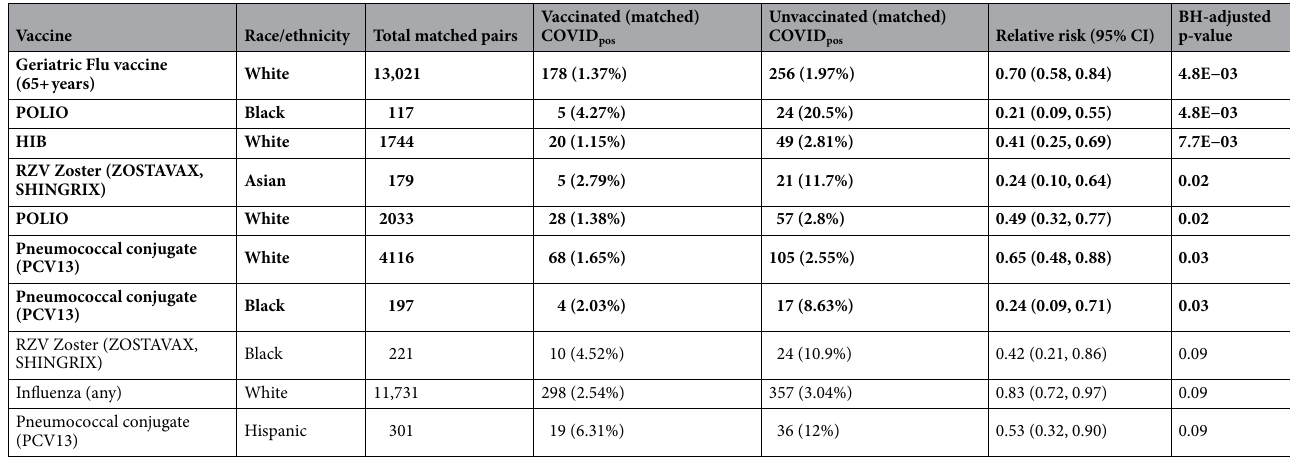
Table 7. Summary of SARS-CoV-2 rates for race/ethnicity-stratified vaccinated and unvaccinated propensity score matched cohorts (1 year time horizon). Table of SARS-CoV-2 infection rates for vaccinated and unvaccinated (matched) race/ethnicity subgroup cohorts for vaccines administered within 1 year prior to PCR testing. Only rows with adjusted p-values ≤ 0.1 are included. Rows in which the SARS-CoV-2 rate is lower (adjusted p-value < 0.05) in the vaccinated cohort are highlighted in bold. The columns are (1) Vaccine: Name of the vaccine, (2) Race/ethnicity: Race/ethnicity subgroup, (3) Total matched pairs: Number of pairs from the propensity matching procedure, which is the sample size of both vaccinated and unvaccinated cohorts after matching, (4) Vaccinated (matched) COVID pos : Number of COVID pos cases among the vaccinated (matched) cohort, along with the percentage in parentheses, (5) Unvaccinated (matched) COVID pos : Number of COVID pos cases among the unvaccinated (matched) cohort, along with the percentage in parentheses, (6) Relative risk (95% CI): Relative risk of COVID pos in the vaccinated (matched) cohort compared to the unvaccinated (matched) cohort, along with 95% confidence interval in parentheses, (7) BH-adjusted p-value: Benjamini–Hochberg-adjusted Fisher exact test